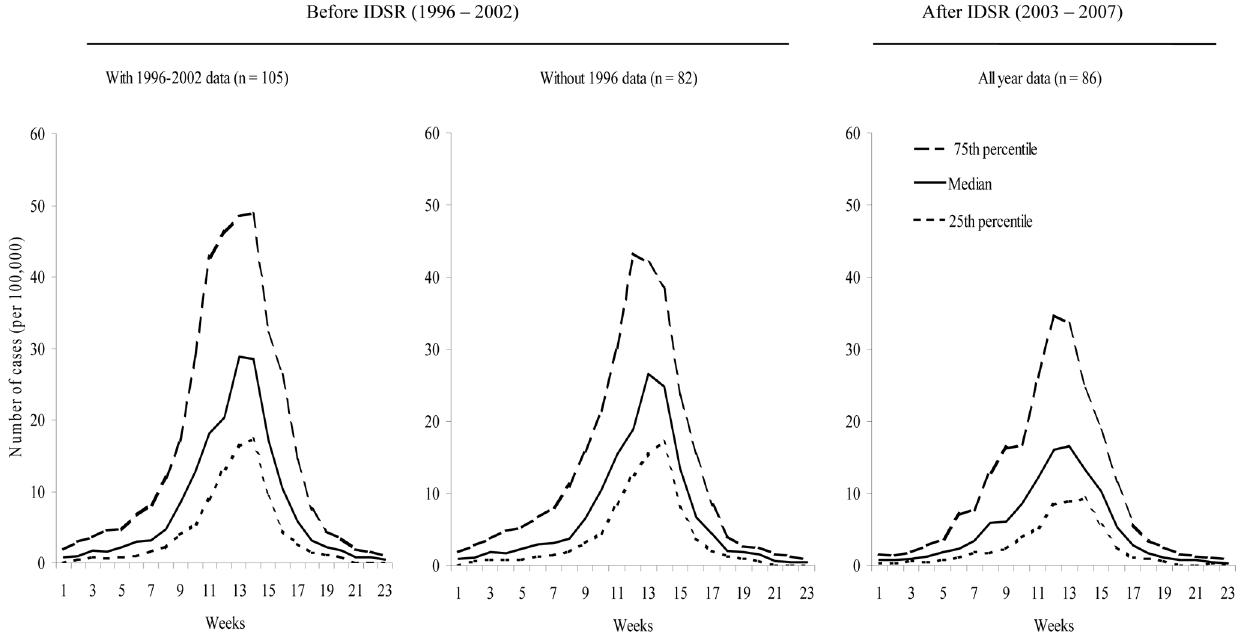
Figure 2. Comparison before (1996–2002) and after (2003–2007) IDSR implementation: weekly median (25 th and 75 th percentiles) of new cases of meningitis per outbreak. Note: Data source: WHO Multi-Diseases Surveillance Center, Ouagadougou, Burkina Faso. For each weekly incidence rate, we calculated the median, 25 th and 75 th percentile of the 105 and 82 outbreaks before IDSR and 86 outbreaks after IDSR. Before IDSR, the median (25 th and 75 th percentile) cumulative number of meningitis cases per outbreak was 185.0 (139.5 and 377.0) per 100,000 inhabitants when 1996 data were included and was 167.9 (135.3 and 281.0) per 100,000 inhabitants when 1996 data were excluded. After IDSR, the median (25 th and 75 th percentile) cumulative number of deaths per outbreak was 142.0 (100.3 and 248.2) per 100,000 inhabitants.